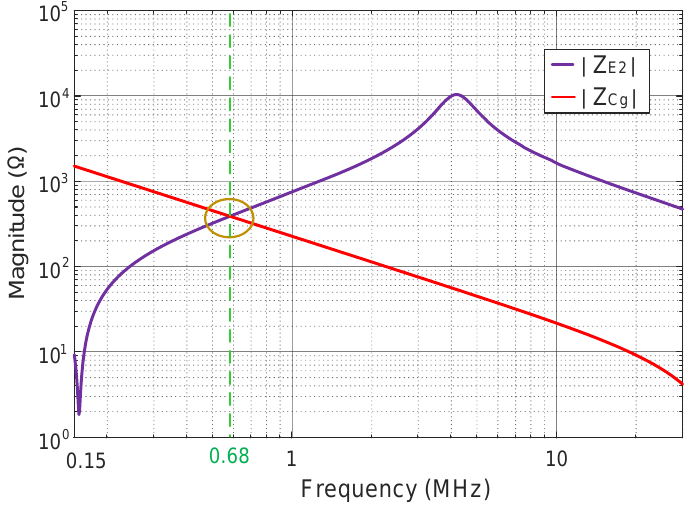
Figure 16. Impedance comparison between Z E2 (250 µ H and 4.7 nF) and Z Cg .